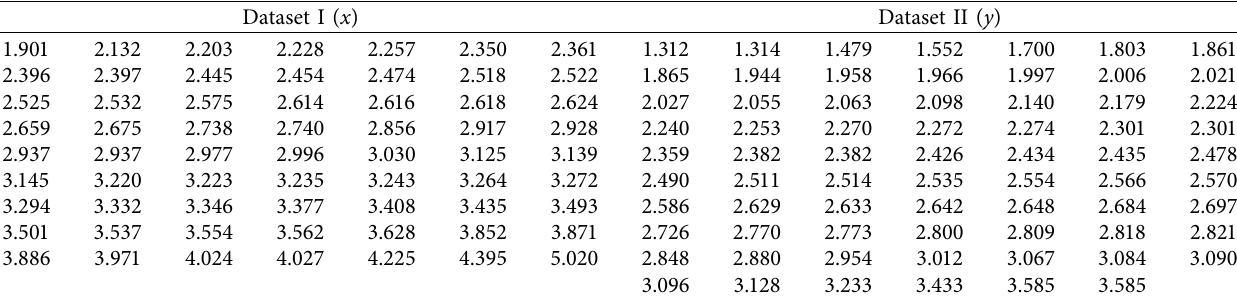
Table 5: The real datasets.